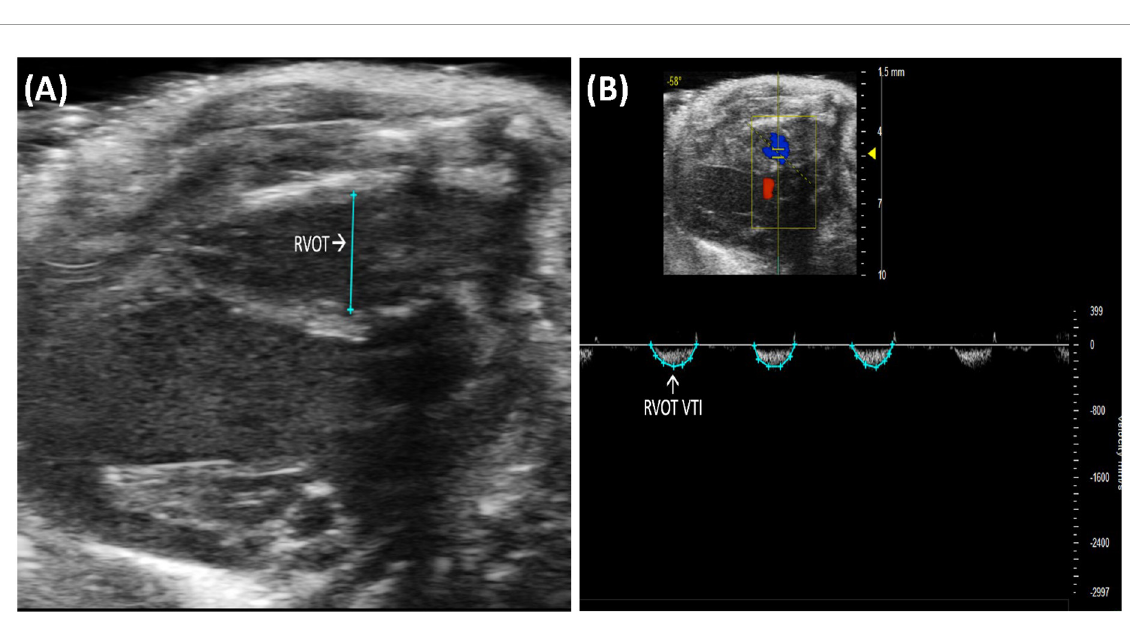
calculated. RVOT VTI is a surrogate for RV stroke volume (SV), hence, the ratio of RVOT VTI to pulmonary artery systolic pressure represents pulmonary arterial compliance, an